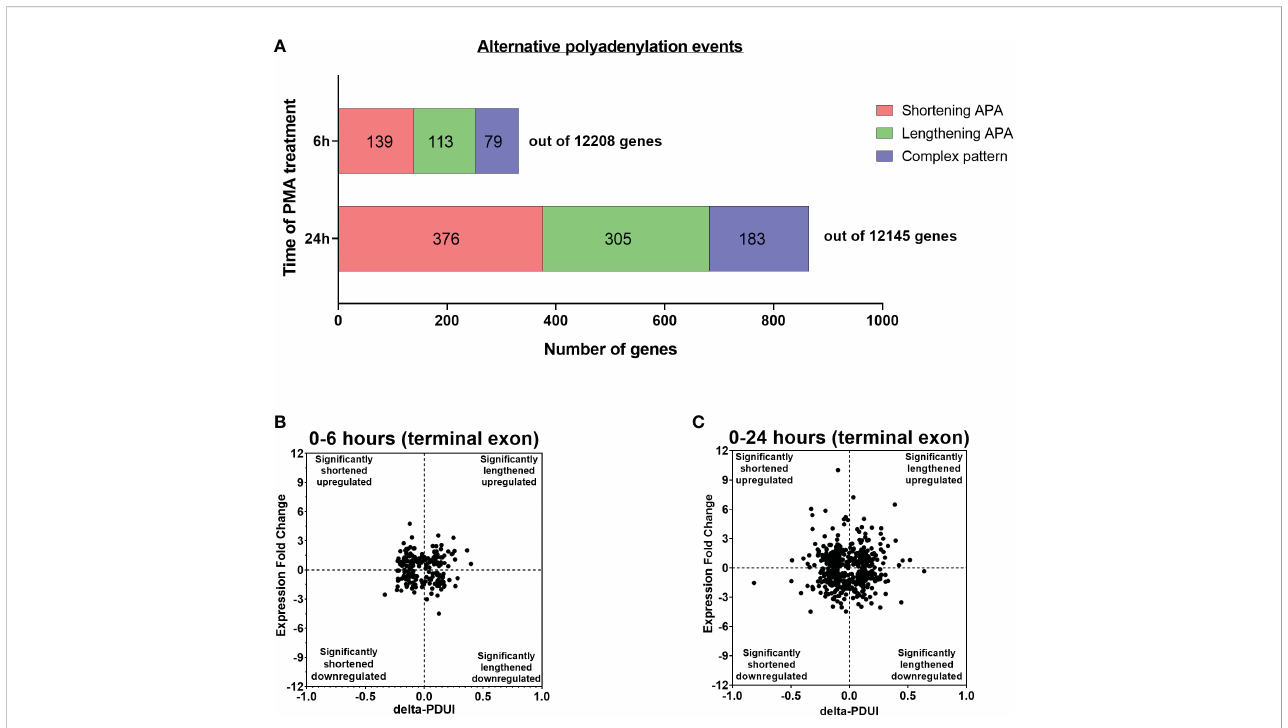
FIGURE 2 Evidence of APA in U937 cells after 6 and 24 hours of PMA treatment. (A) Bar graph representing the numbers of genes with APA changes in the terminal 3 ’ UTR after 6h and 24h of PMA treatment with respect to control undifferentiated U937 cells. Red, green and blue represents shortening, lengthening and complex (where some went up and others went down) APA patterns in the dataset. The criteria for a signi fi cant APA change is that at least one PAC in an exon must change greater than 1.5 fold with p Adj <0.1, resulting in a difference in fractional usage of that PAC of at least 10%. (B, C) Log 2 -fold change in gene expression is plotted against the change in Percentage of Distal poly(A) site Usage Index (delta-PDUI) for 3 ′ -UTR-altered genes in 6h PMA-treated U937 cells with respect to control undifferentiated ones (B) or in 24h PMA-treated U937 samples (C) . Plots for fold change vs poly(A) site usage (delta PDUI) where genes on the left half of each graph represent 3 ′ -UTR-shortened hits, whereas those on the right half represent 3 ′ -UTR lengthened